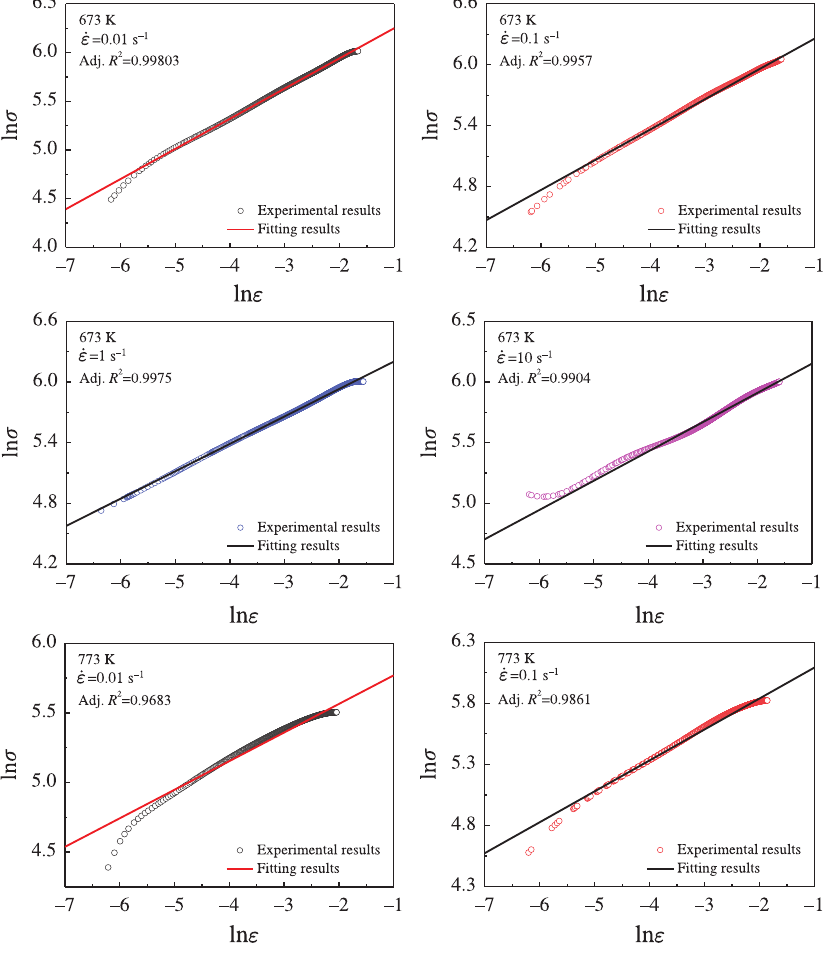
Figure 11: The relationships between ln σ -ln ε under different temperatures and strain rates.